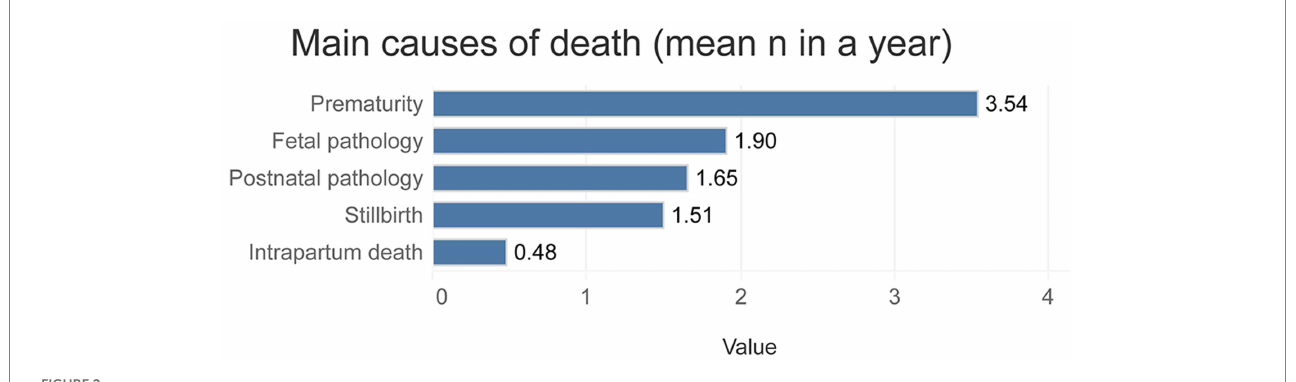
FIGURE 2 Main causes of neonatal death faced by HCPs.